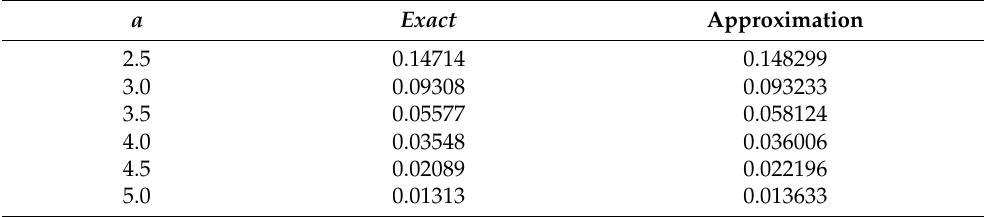
Table 1. Tail probabilities for several values of a and sample size n ( h , τ ) = 3.